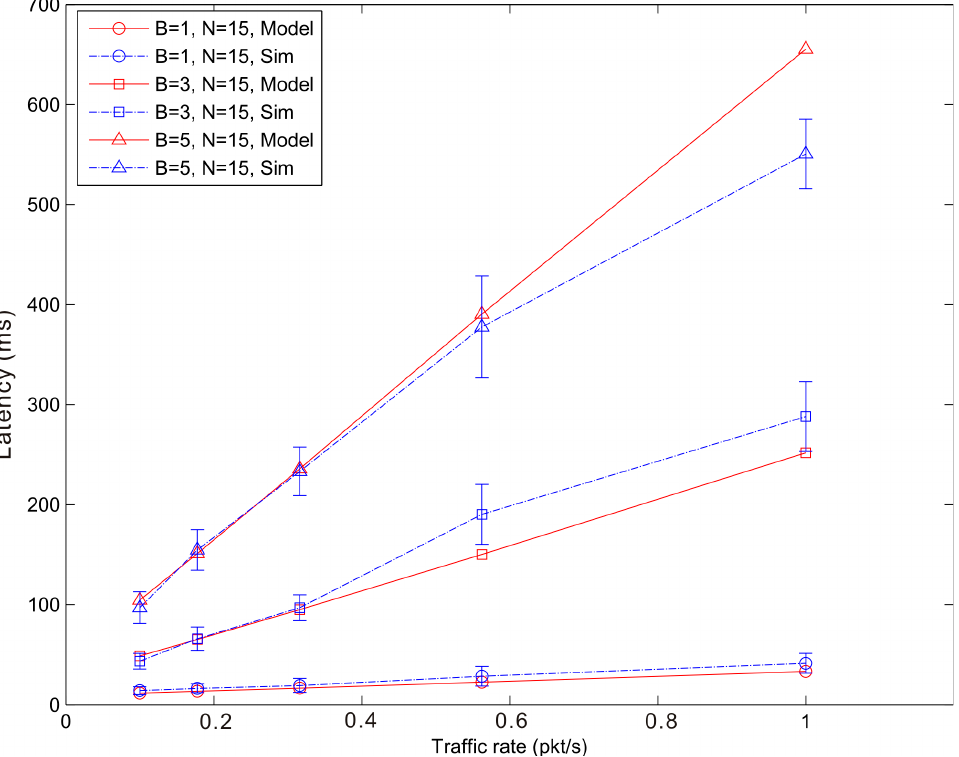
Figure 15. Blockwise Latency versus traffic rate for a star topology network composed by 15